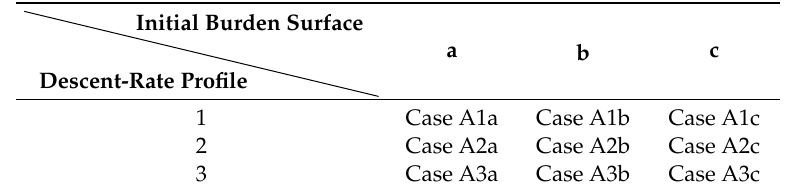
Table 2. Simulation schemes with di ff erent descent-rate and initial burden surface profiles (cf. Figures 4 and 5). The rings of the charging matrix of Table 1 were charged from the wall to the center (denoted by